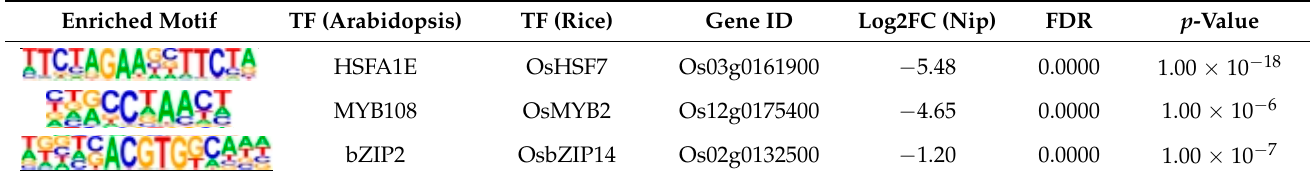
ods. The plot on the left side represents the RT-qPCR measurement results, while the right side